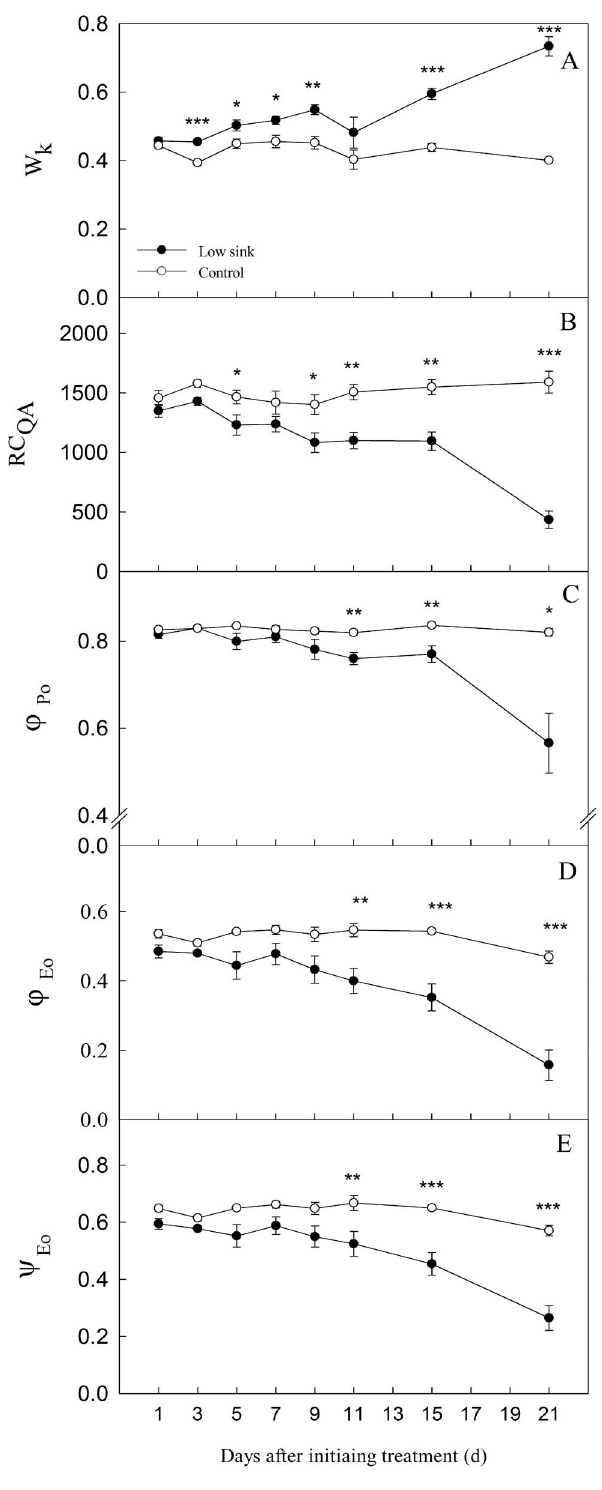
Figure 4. The change in parameters including W k, RC QA , Q Po , Q Eo and y Eo involved in electron transport chain of PSII in bean ( V. faba L.) source leaves at 1300 h from the 1 st to 21 st day after removing the sink of roots and pods. Each value represents the mean of five replicates, and error bars represent 6 S.E. The asterisks *, ** and *** indicate significant difference at P , 0.05, 0.01 and 0.001 between the control and treatment, respectively.